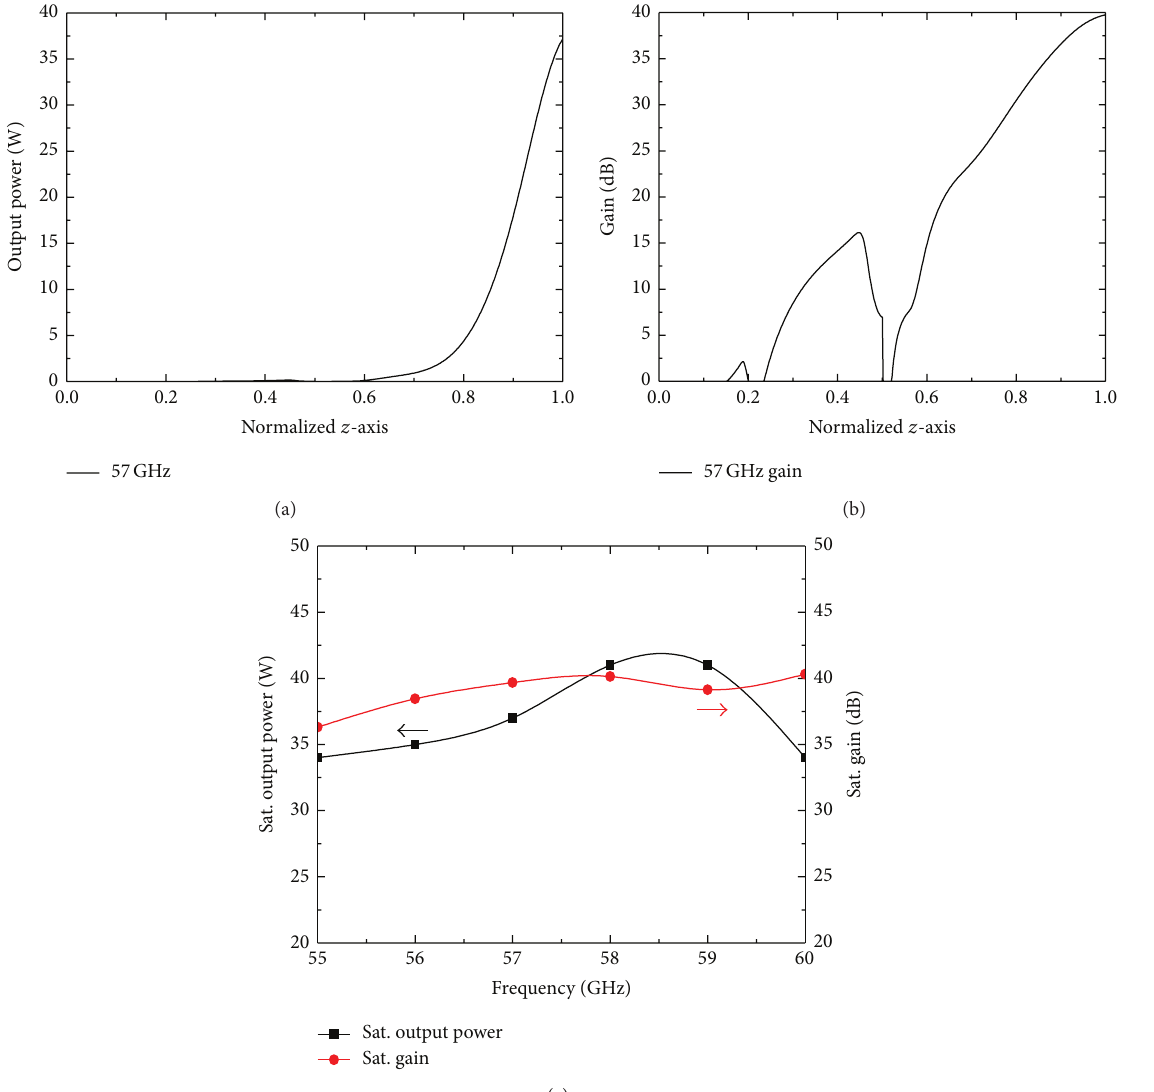
Figure 6: (a) Output power versus 𝑧 at 57 GHz, (b) gain versus 𝑧 at 57 GHz, and (c) saturated output power and saturated gain ranging from 55 GHz to 60 GHz.